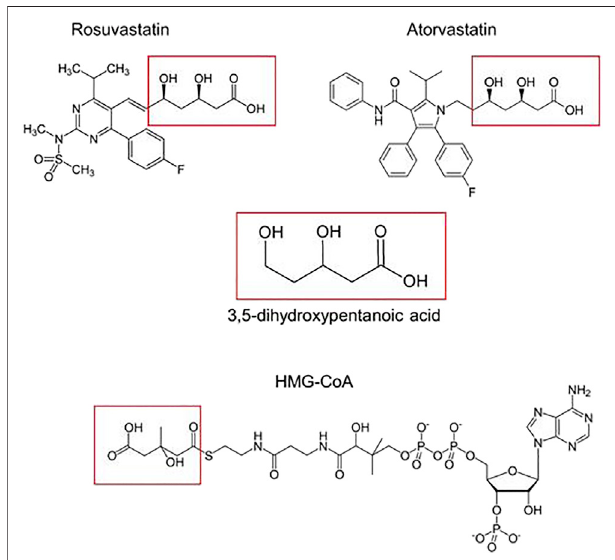
FIGURE 11 | Pharmacophore group of statins. The 3,5- dihydroxypentanoic acid is the common core among all statins and is responsibleforinhibitingtheenzyme3-hydroxy-3-methylglutaryl – coenzymeA reductase (HMGR). These monocarboxylated portions (highlighted in red) mimic the anchorage site of 3-hydroxy-3-methylglutaryl-coenzyme A (HMG-CoA) in the reductase enzyme, during the reductive deacylation step in cholesterol